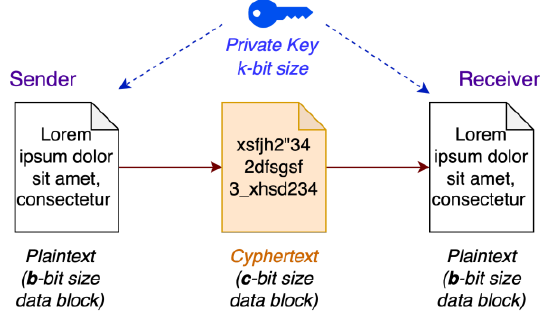
Figure 5. Block cipher with a symmetric key.